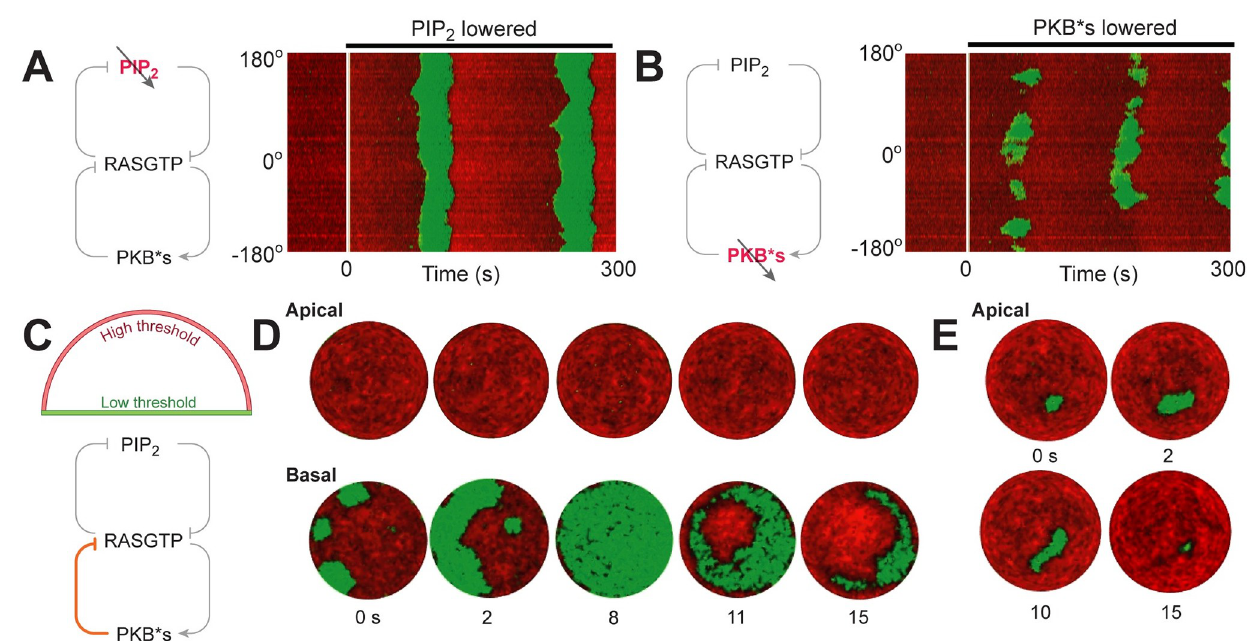
Fig 7. Effect of threshold on STEN dynamics. (A,B) The kymographs show the effect of lowering the STEN threshold by inhibiting PIP 2 (A) and PKB � s (B) as denoted in the schematics. The white lines indicate the time at which the respective species were lowered. (C) Schematic for incorporating the differential threshold between top and bottom surface of the cell through altering the PKB � s mediated inhibition on RasGTP. (D) Increased threshold restricts the wave activities at the basal surface and the waves were not allowed to travel to the apical surface. (E) Higher threshold on the apical surface made small waves with fewer number of wave